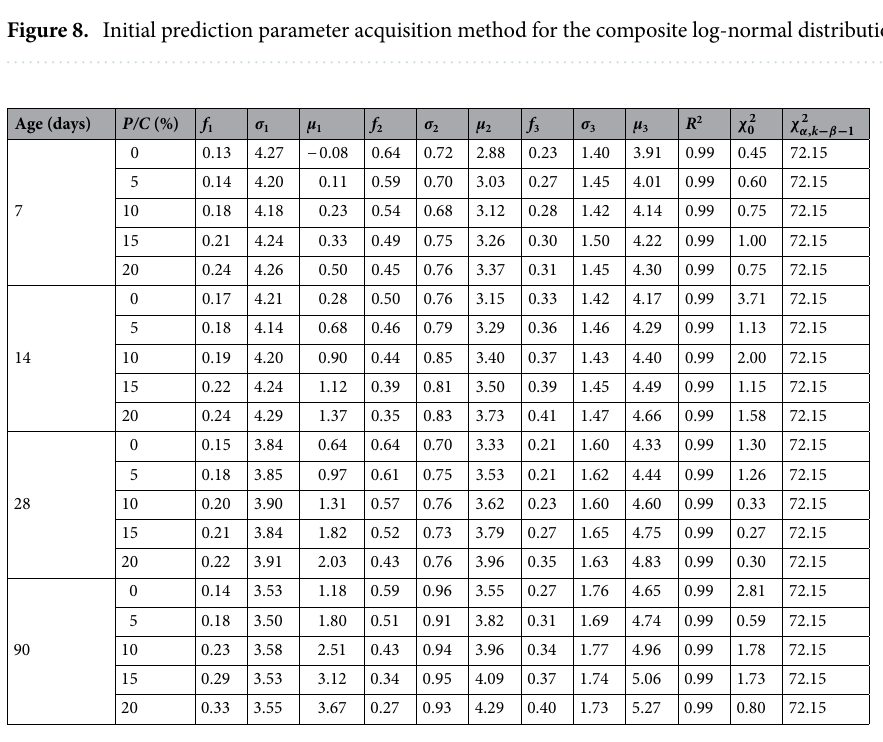
Table 3. Compound log-normal distribution parameters for the pore size distributions of epoxy latex- modified